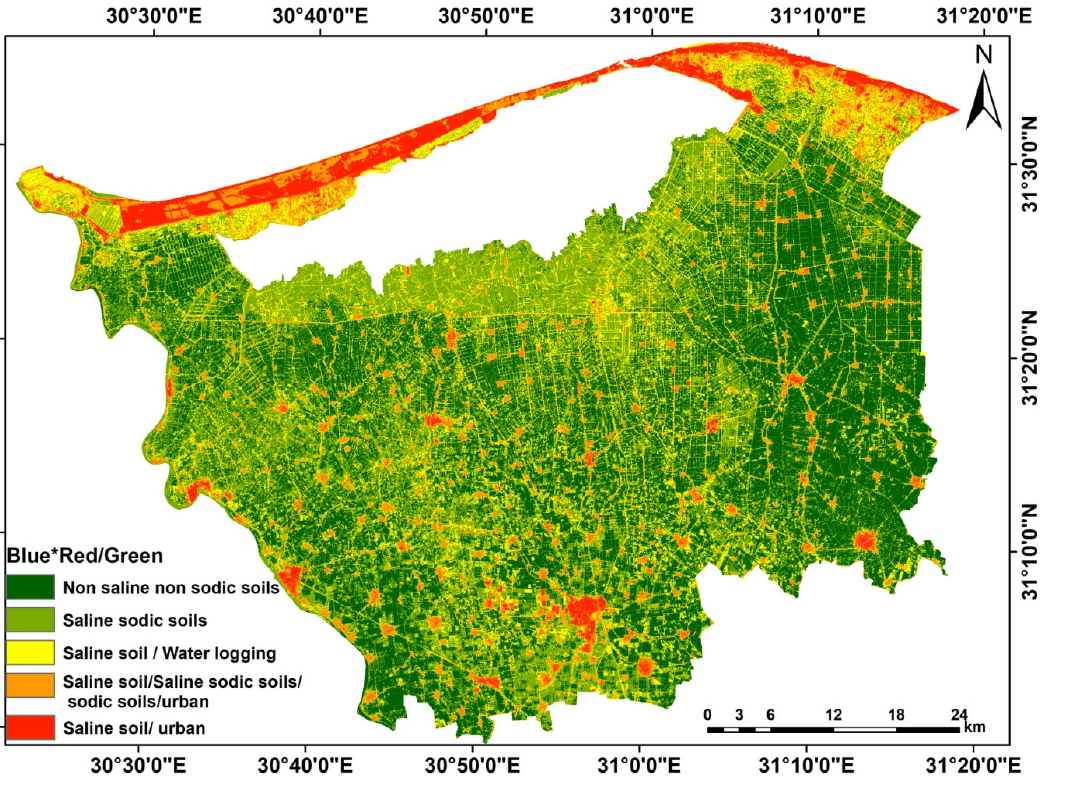
was an overlap with waterlogged, dry sabkhas, and low-density urban areas (in yellow). The model observed the nonsaline and nonsodic areas in high accuracy (dark green). For the second part of the equation, as shown in Figure 5, the model succeeded in recognizing the waterlogged, fish farms, and dry sabkhas in an accurate way in red. In ad- dition, for the highly saline and highly sodic areas that are presented in orange, the model succeeded in configuring slightly to moderately saline, moderately sodic soils (yellow col-